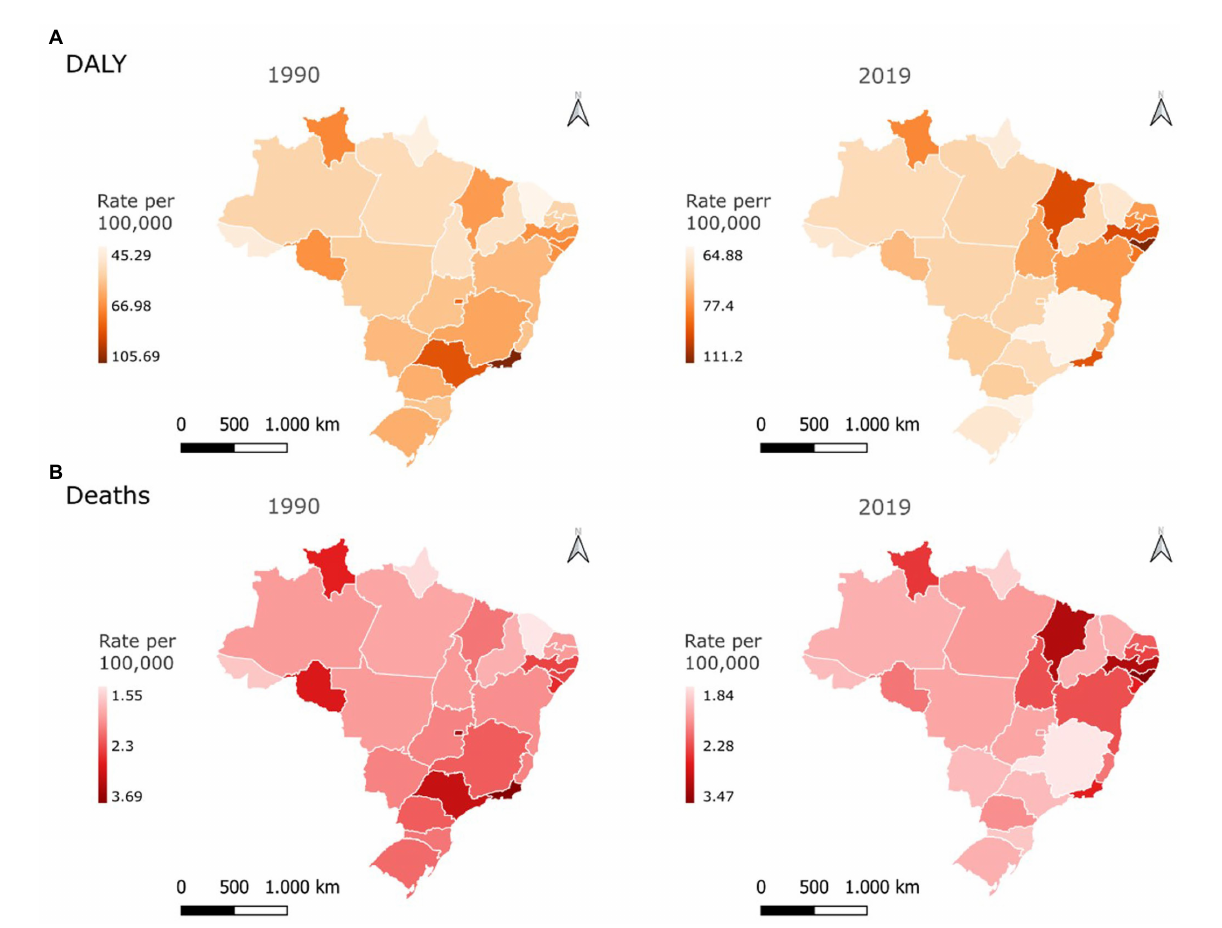
FIGURE 2 Age-standardized disability–adjusted life years (A) and deaths (B) rates per 100,000 inhabitants for chronic noncommunicable diseases attributable to a diet rich in processed meat for both sexes in the federative units of Brazil in 1990 and